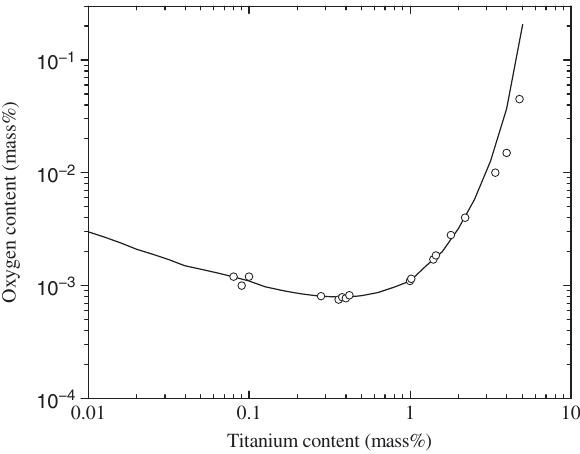
Figure 3: Influence of Ti element on the oxygen solubility in liquid iron at 1,873 K (reproduced from Ref. [8]).